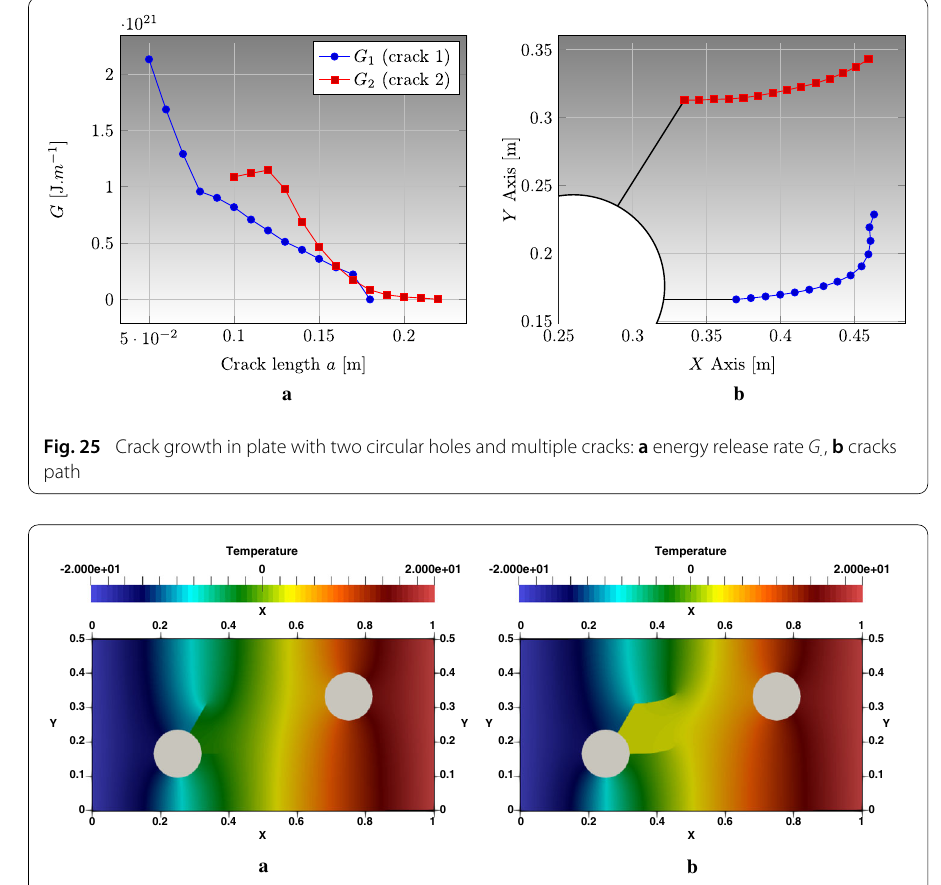
Displacements are more pronounced over e y direction; Fig. 27a, b stand for respectively e y -displacement at initial state and at 13 (cid:14) a